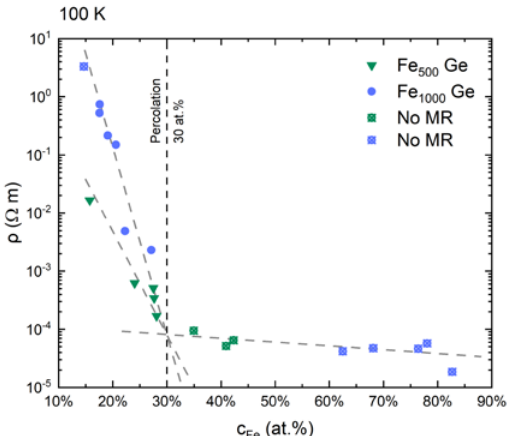
Figure 12. Resistivity at 100 K vs. Fe concentration of Fe-Ge nanocomposite films. Green triangles represent nanocomposites containing Fe 500 , blue circles those containing Fe 1000 . At concentrations above 30 at.% the resistivity’s order of magnitude is in accordance with minimum metallic conduction